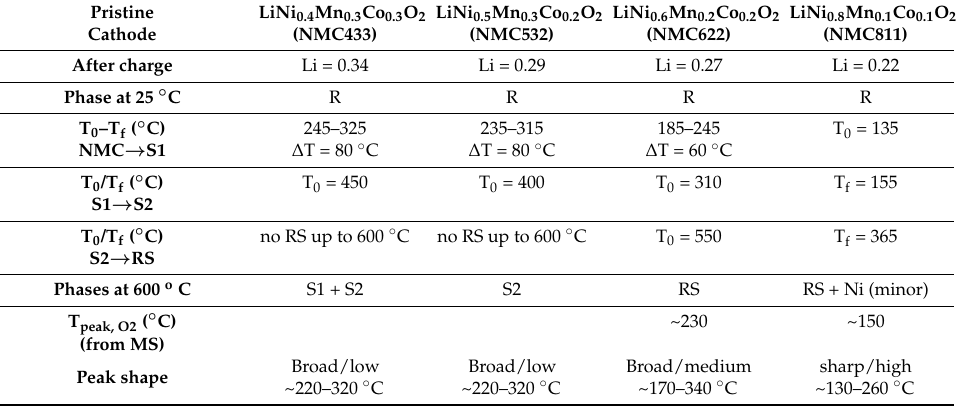
Table 1. Phase transformation temperatures obtained from operando HTXRD and the peak temperature of oxygen release from